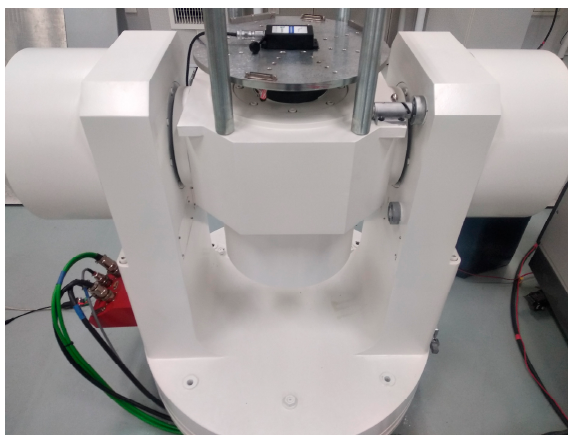
Figure 13. Two-axis rotator for MEMS inclinometer testing.